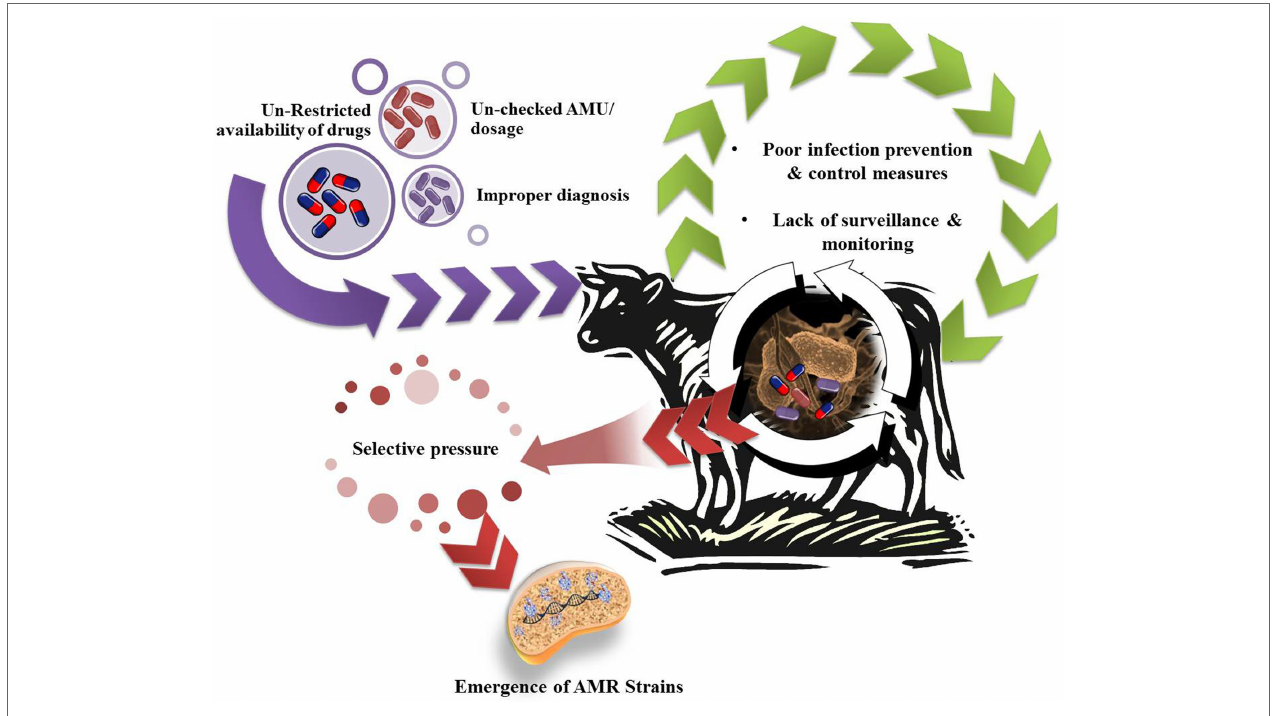
FiGURe 1 | Possible factors leading to antimicrobial resistance (AMR) in dairy